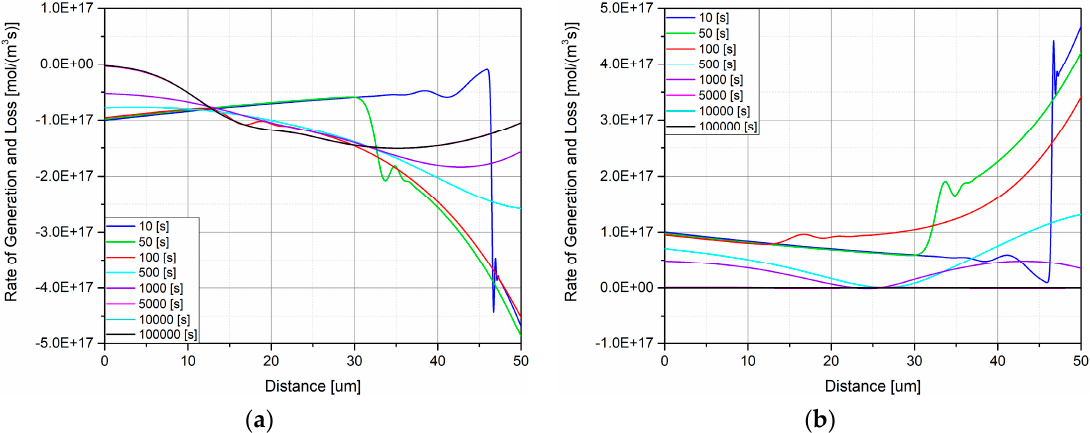
Figure 4. Rates of generation and loss of carriers at 40 °C: ( a ) mobile carriers; ( b ) trapped carriers.